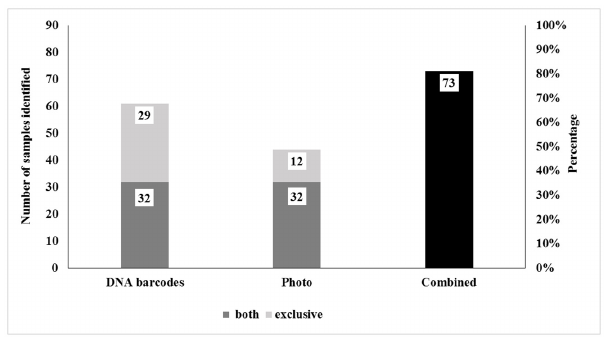
Fig 3. Number of samples and percentage of samples identified using DNA barcoding, photo identification and combined methods, respectively.